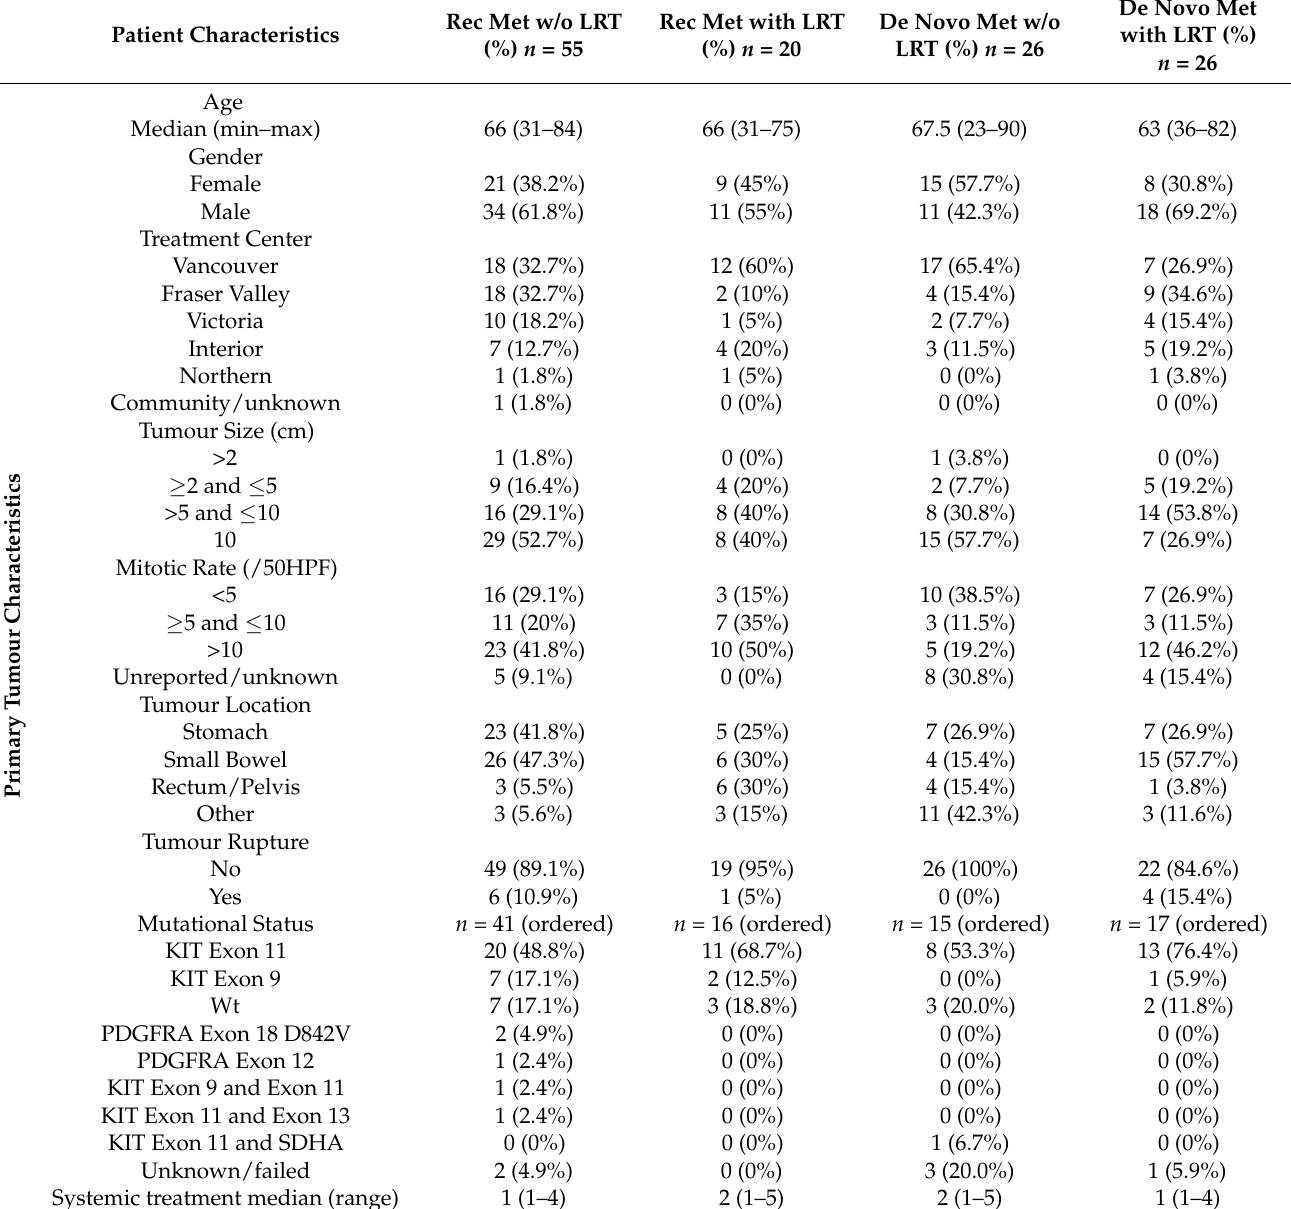
Table 1. Overview of cohort characteristics–metastatic Gastrointestinal Stromal Tumors (GIST) in British Columbia (BC) (January 2008–December